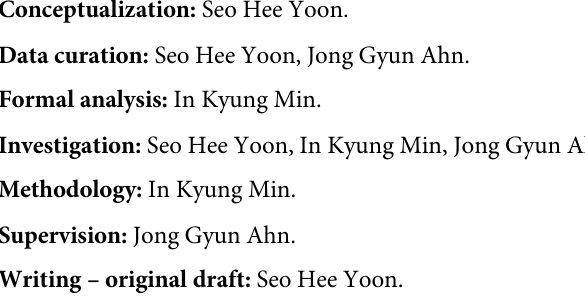
S1 Table. Demographics of the studies included in the current meta-analysis. S2 Table. Quality assessment of enrolled studies using the Quality Assessment of Diagnos- tic Accuracy Studies 2 (QUADAS-2) tool. S3 Table. Covariate significance test using bivariate random-effect model. S4 Table. Summary estimates of the diagnostic accuracy according to index test assay to diagnose Mycoplasma pneumoniae . S1 Fig. Funnel plot of the studies included in the current meta-analysis. S2 Fig. Summary receiver operating characteristic (ROC) curves of the diagnostic accuracy of Ribotest Mycoplasma 1 for Mycoplasma pneumoniae infection. Summary points of the sensitivity and specificity, summary receiver operating characteristic (SROC) curve, 95% con- fidence region, and 95% prediction region are shown. The area under the curve of the SROC for the immunochromatographic tests (ICTs) was